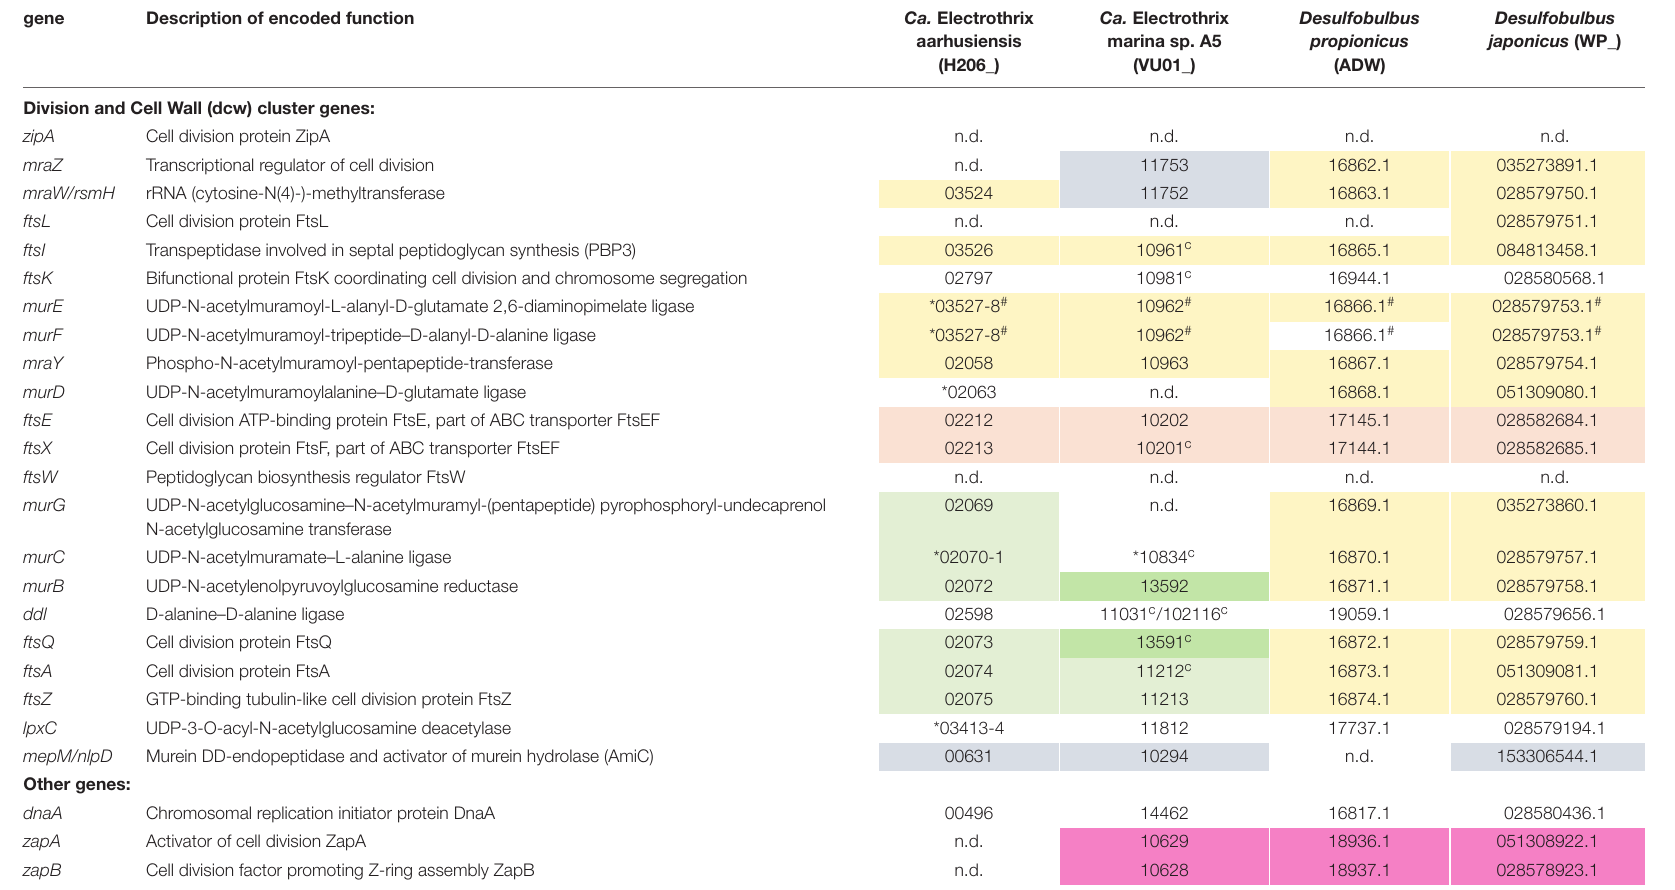
TABLE 2 | Genes putatively involved in cell division present in genomes of cable bacteria and Desulfobulbus spp. gene Description of encoded